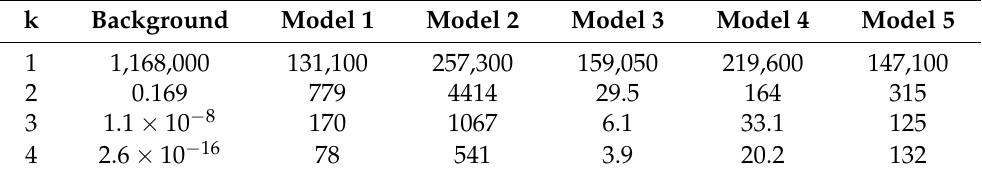
background and predicted by different models for the measurements during one week, with the assumption that all particles from each cascade can reach the